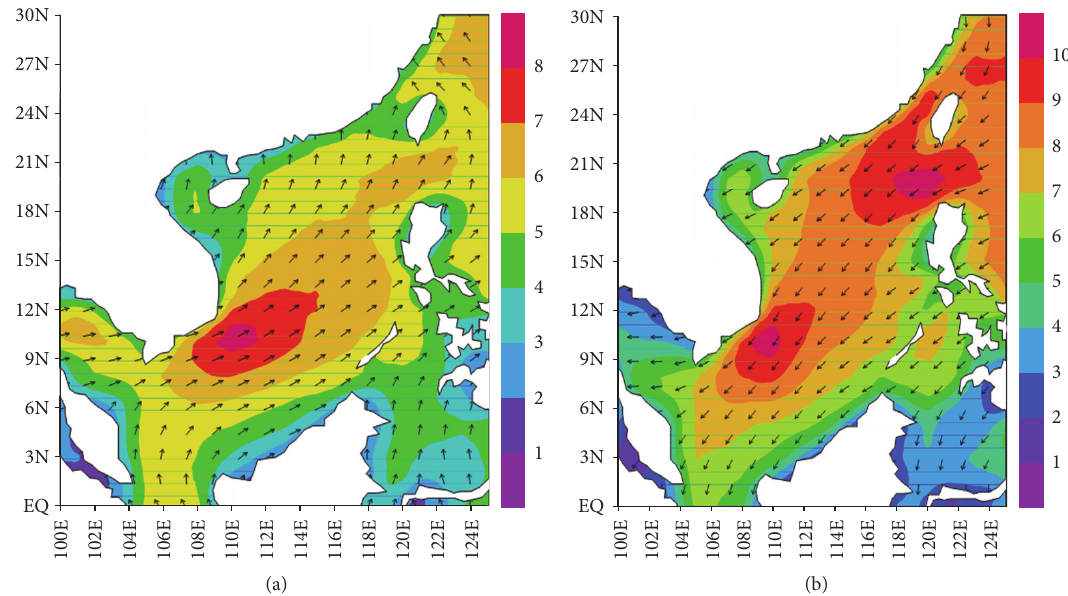
Figure 7: The monthly mean wind speed in the South China Sea. (a) August. (b) January. Unit: